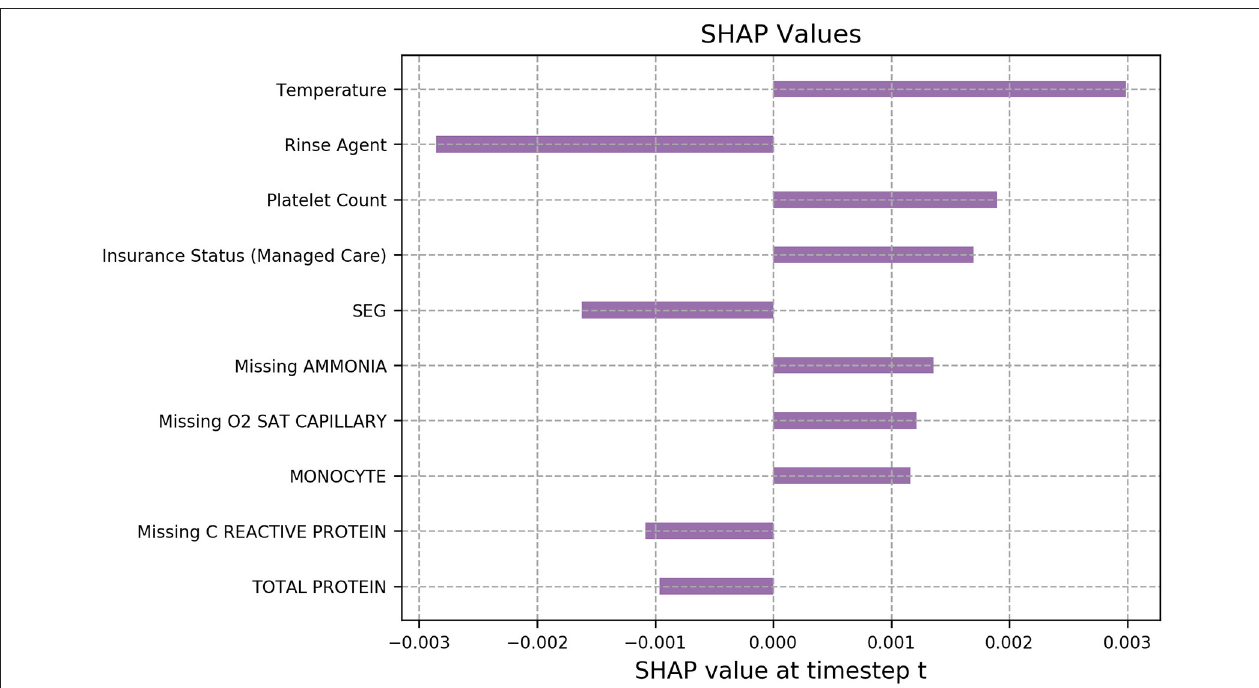
FIGURE 4 | Feature importance plot based on SHAP values for an example prediction in which the model predicted the patient would develop a CLABSI within the next 48h.